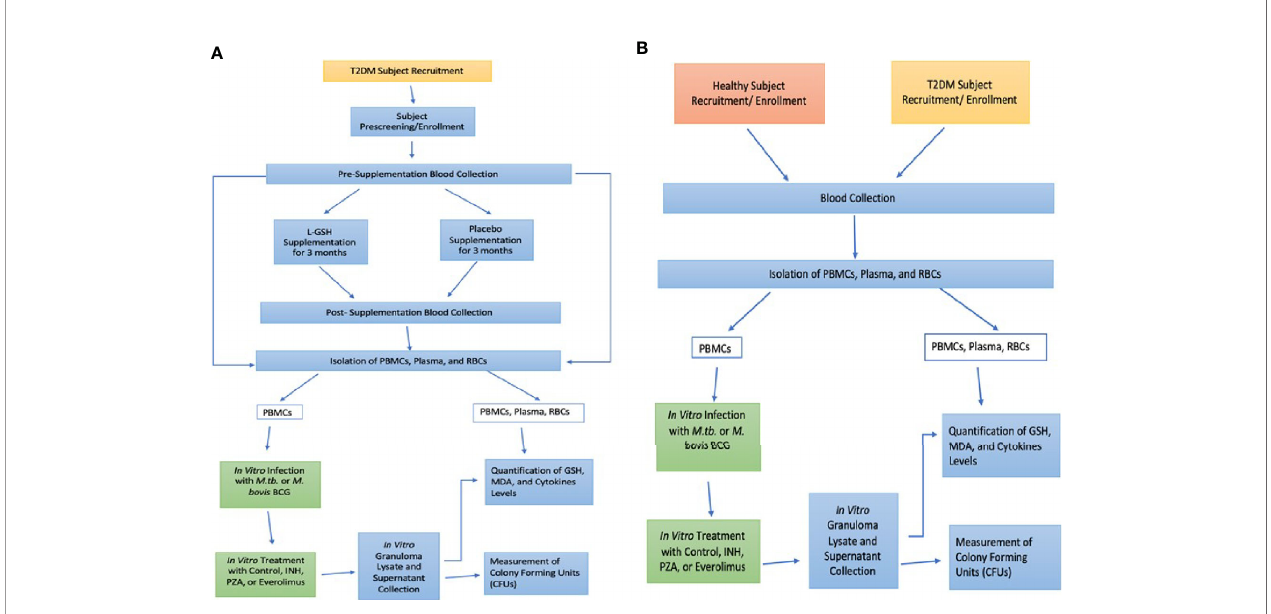
FIGURE 1 | Study Design. L-GSH Clinical Trial Study design in subjects with T2DM (A) and Preclinical Study Design in Healthy and T2DM Subjects (B)